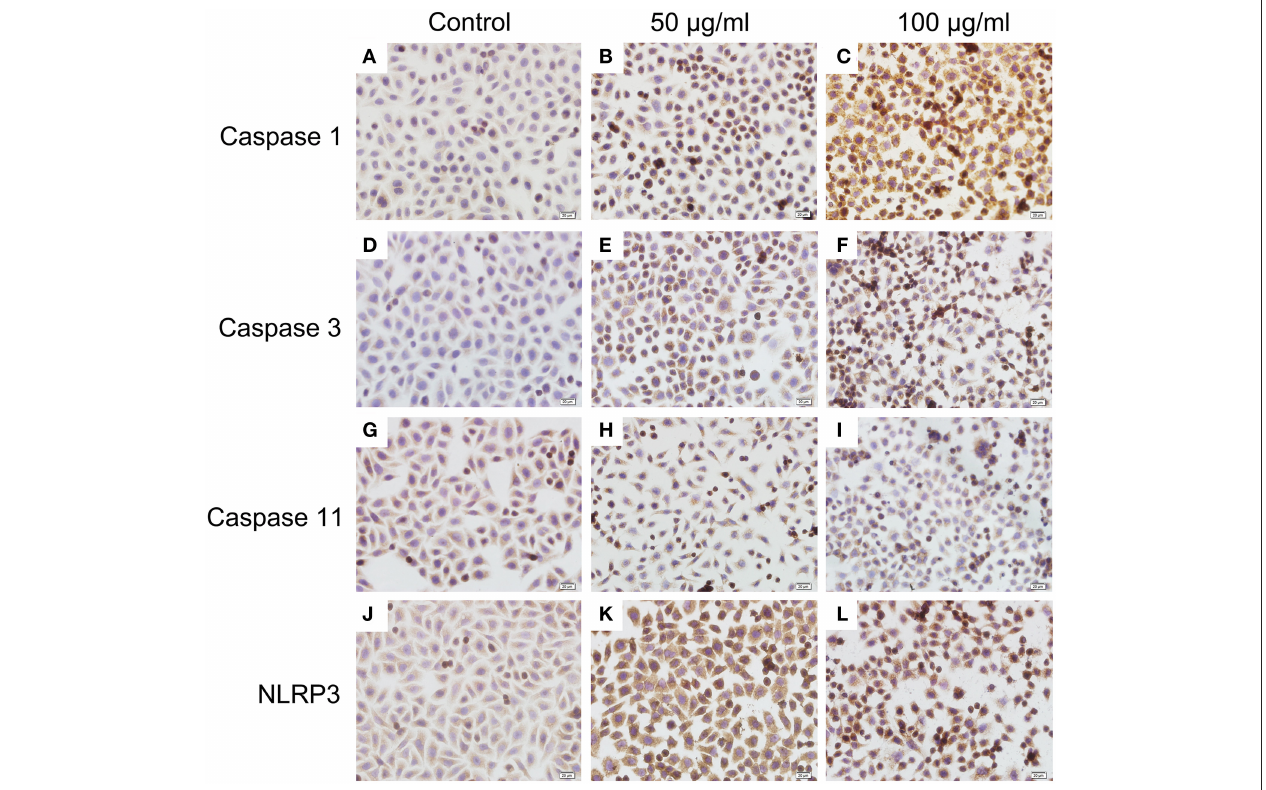
FIGURE 8 | Immunocytochemistry analysis of histone induced activations of caspase 1, caspase 3, and NLRP3 (400 × ). BMECs were cultured briefly on cover glasses (pre-treated with poly-L –lysine, 0.1 mg/mL, Sigma-Aldrich) and incubated with histone (50 and 100 µ g/mL) for 16h. The samples were visualized with DAB, counterstained with hematoxylin and observed by inverted microscope. Three independent experiments were carried out by light microscope